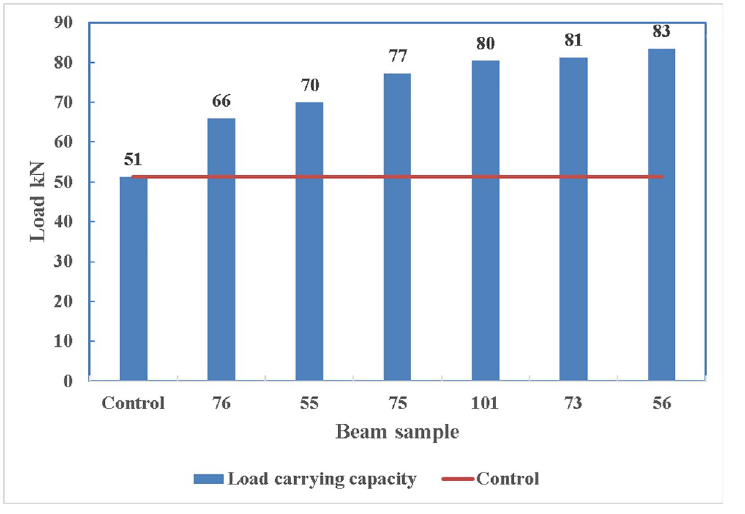
Fig 17. Comparison of load carrying